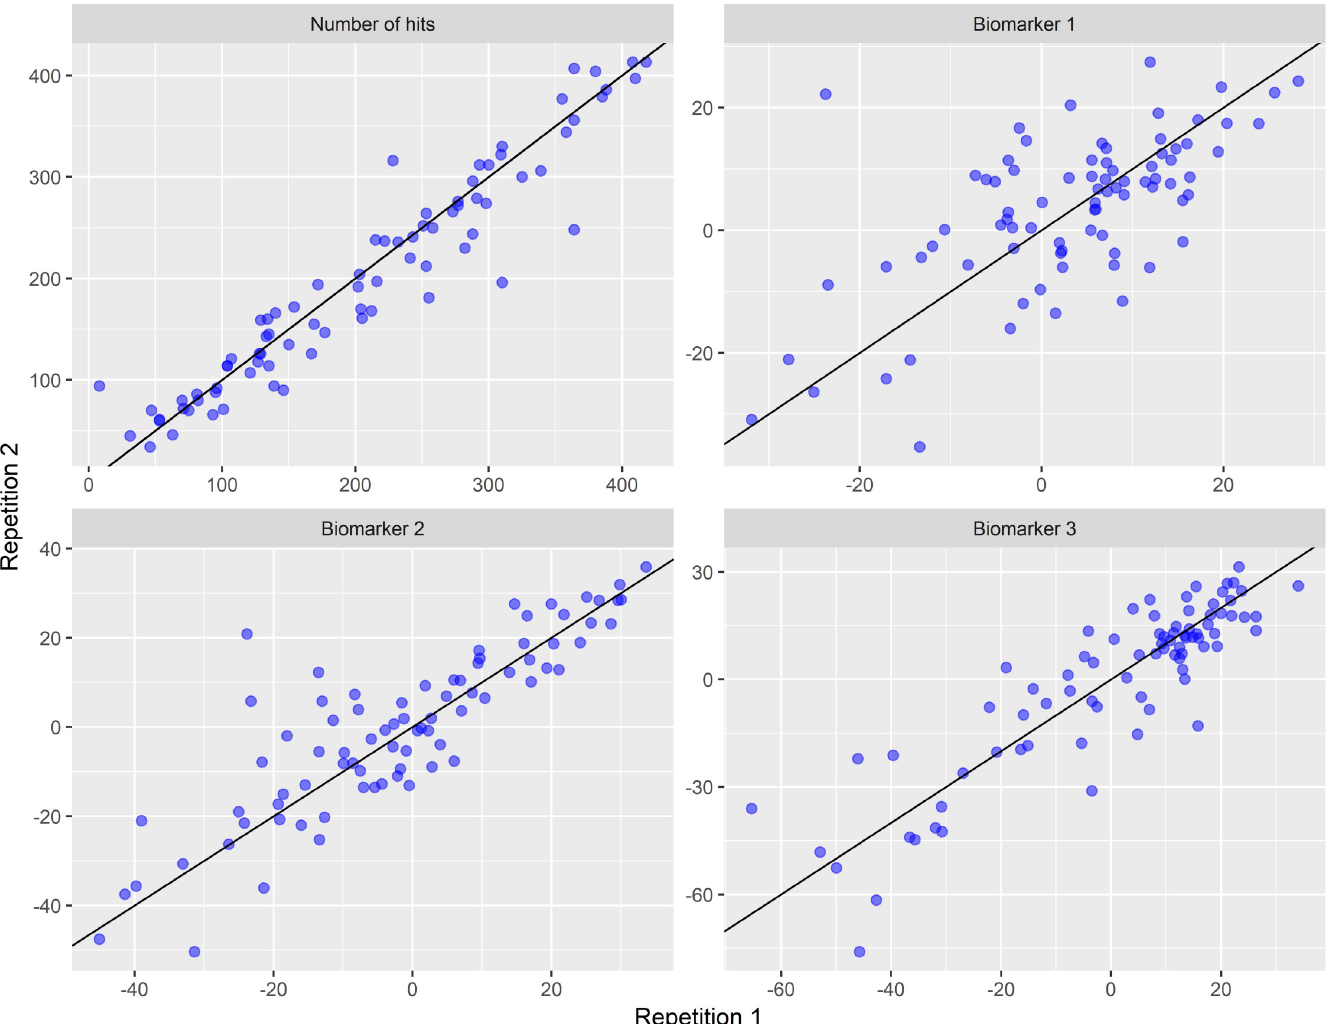
Fig 3. Within-session repeatability of each AE candidate biomarker. Each graph shows the biomarker value obtained from the first set of sit-stand-sit movements (x- axis) plotted against the biomarker value obtained from the repeat set of movements (y-axis). Number of hits contained one outlier at (254, 873). This measurement was omitted from the figure. S1 Fig shows the outlier